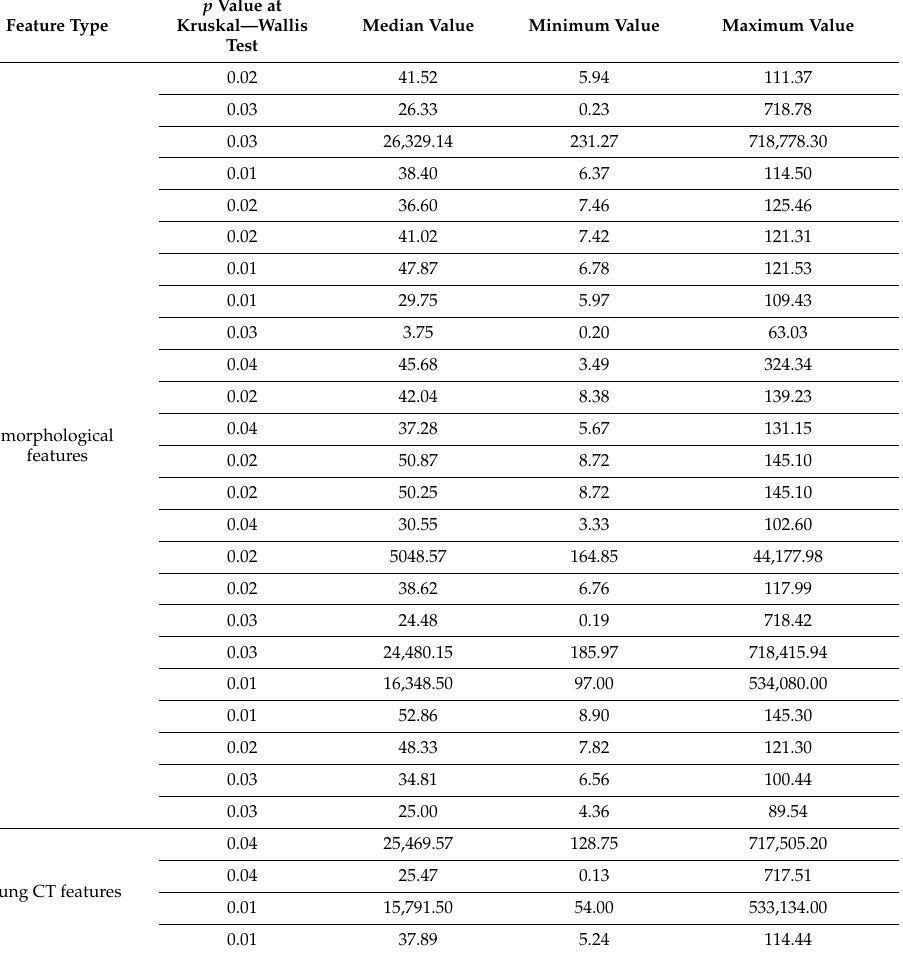
p Value at Kruskal—Wallis Median Value Minimum Test